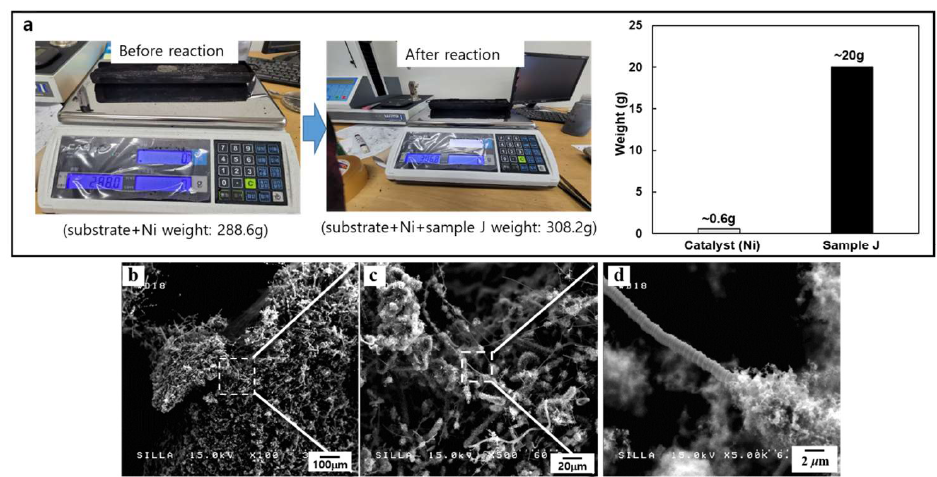
Figure 5. ( a ) Optical photograph for the weighting of sample J, ( b ) FESEM image of sample E, ( c ) magnified-FESEM image of ( b ), and ( d ) high magnified-FESEM image of ( c ).